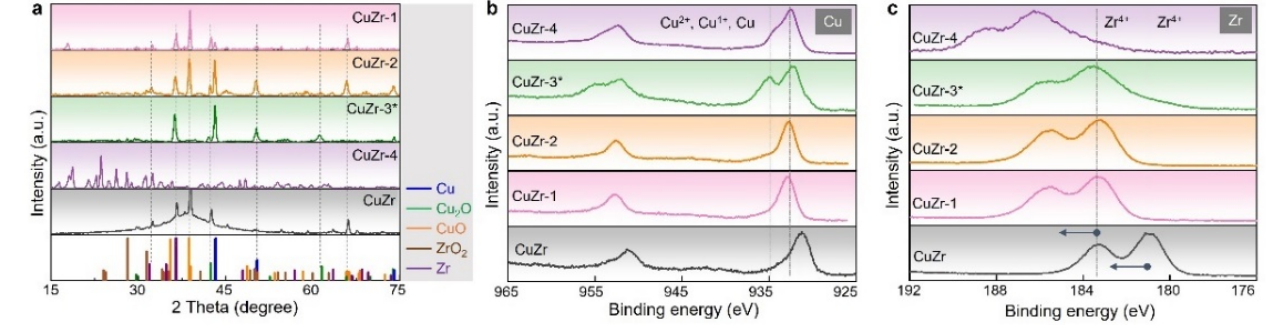
Figure 2. ( a ) XRD patterns of the dealloyed samples of CuZr alloy. ( b ) XPS spectra of ( b ) Cu 2p and ( c ) Zr 3d.